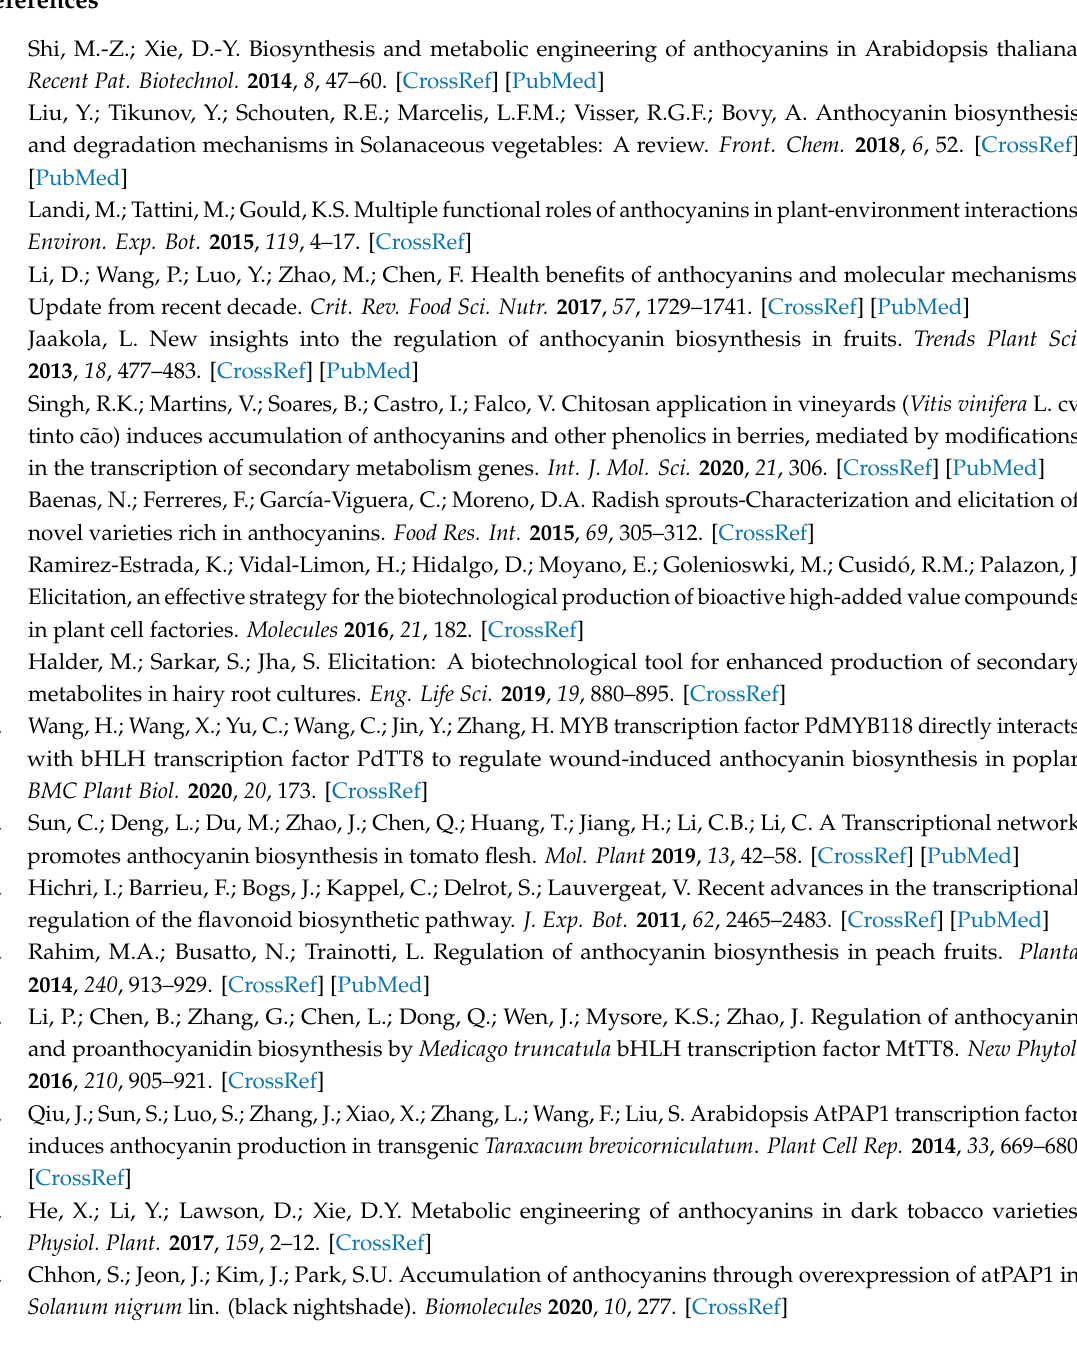
Figure S1. The expression patterns of the selected genes were analyzed using qRT-PCR. Table S1. Primer sequences for PCR analysis. Table S2. Summary of RNA sequencing data from three RNA libraries. Table S3. DEGs involved in phenylpropanoid biosynthesis